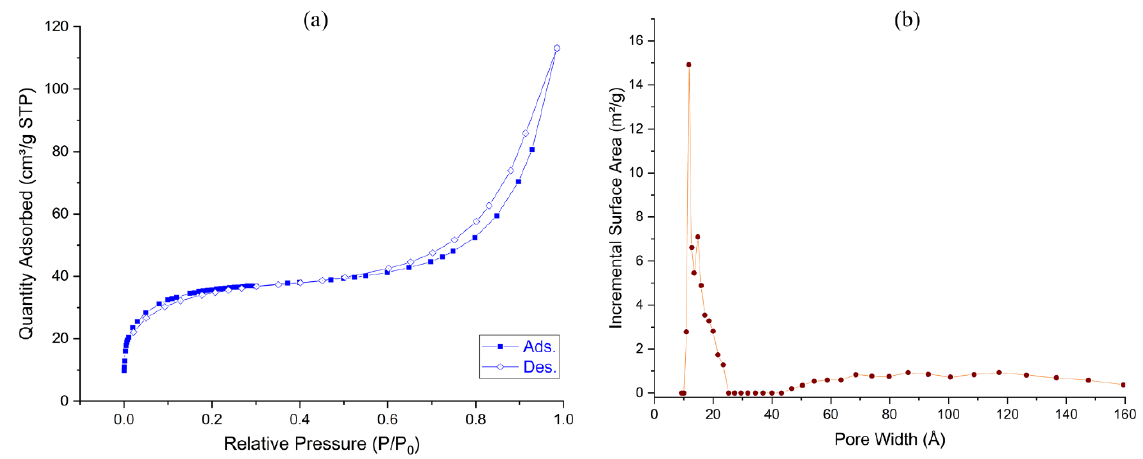
Figure 2. ( a ) Nitrogen adsorption – desorption curves (filled circles: adsorption; open circles: desorp- tion) and ( b ) pore width distribution of Porph-UOZ-COF.